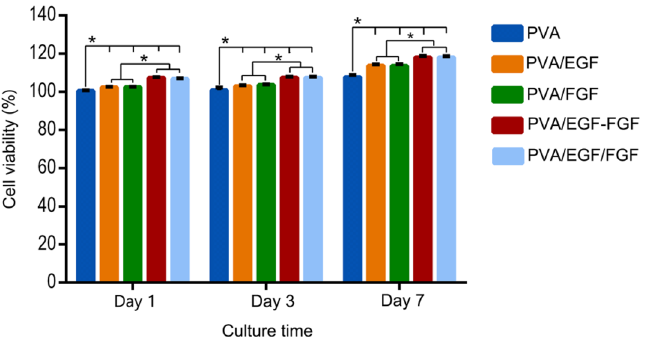
Figure 7. MTT assay data of HDFs after 1, 3 and 7 days cultured on